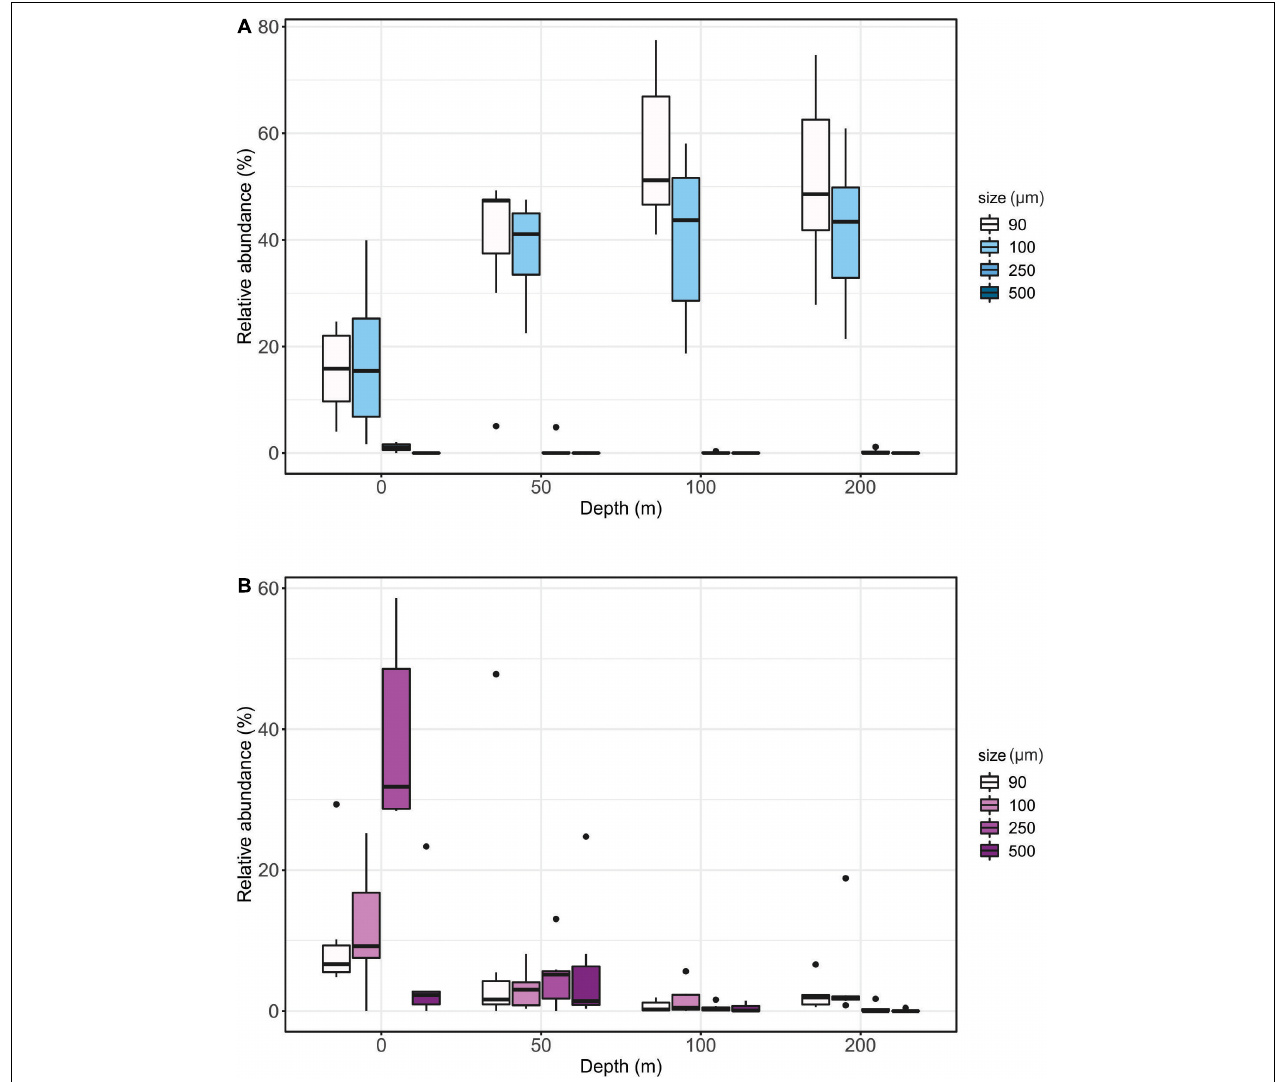
FIGURE 4 | Relative (%) size distribution of planktic foraminifera (A) and pteropods (B) relative to water depth.